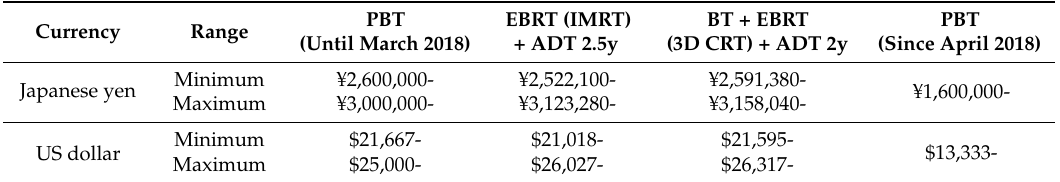
Table 3. Comparison of estimated total costs in 3 patterns of non-operative treatments for localized prostate